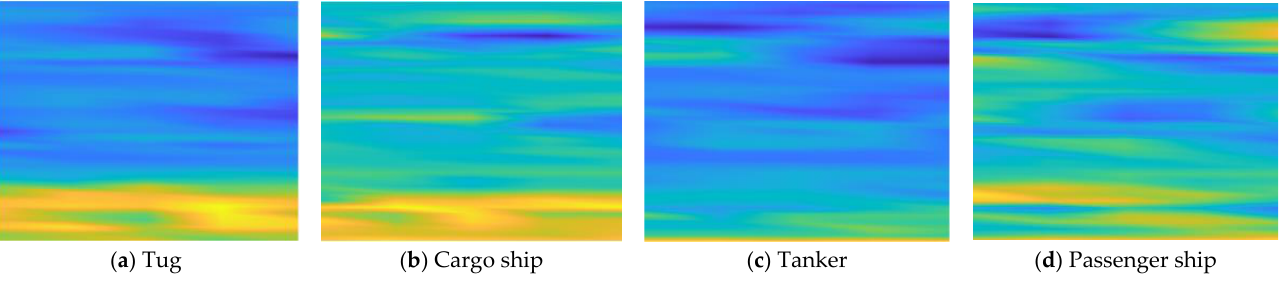
Figure 13. The single image sample of each type of ship.